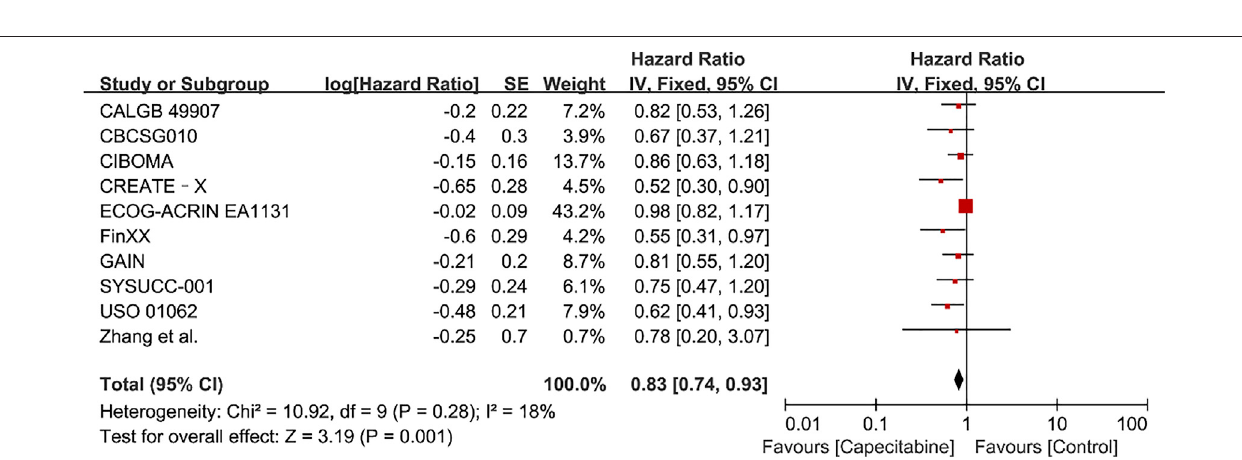
Frontiers in Pharmacology |